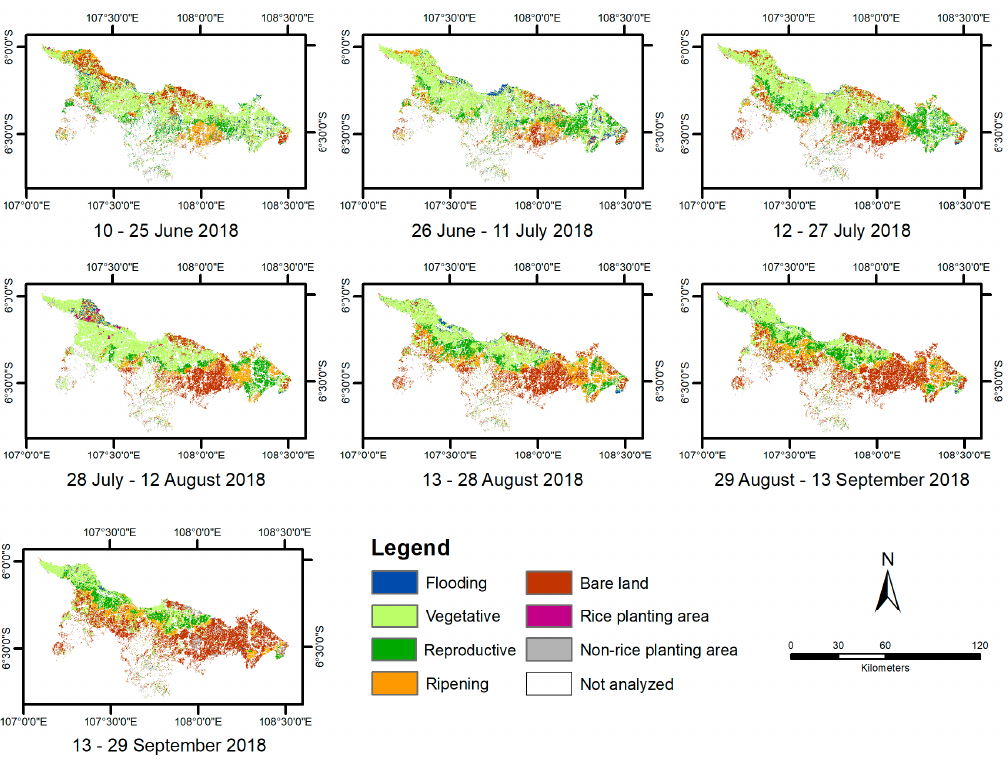
Figure 7. Temporal map of rice growth stages based on Sentinel-2/MOD13Q1/Sentinel-1 on the West Area.